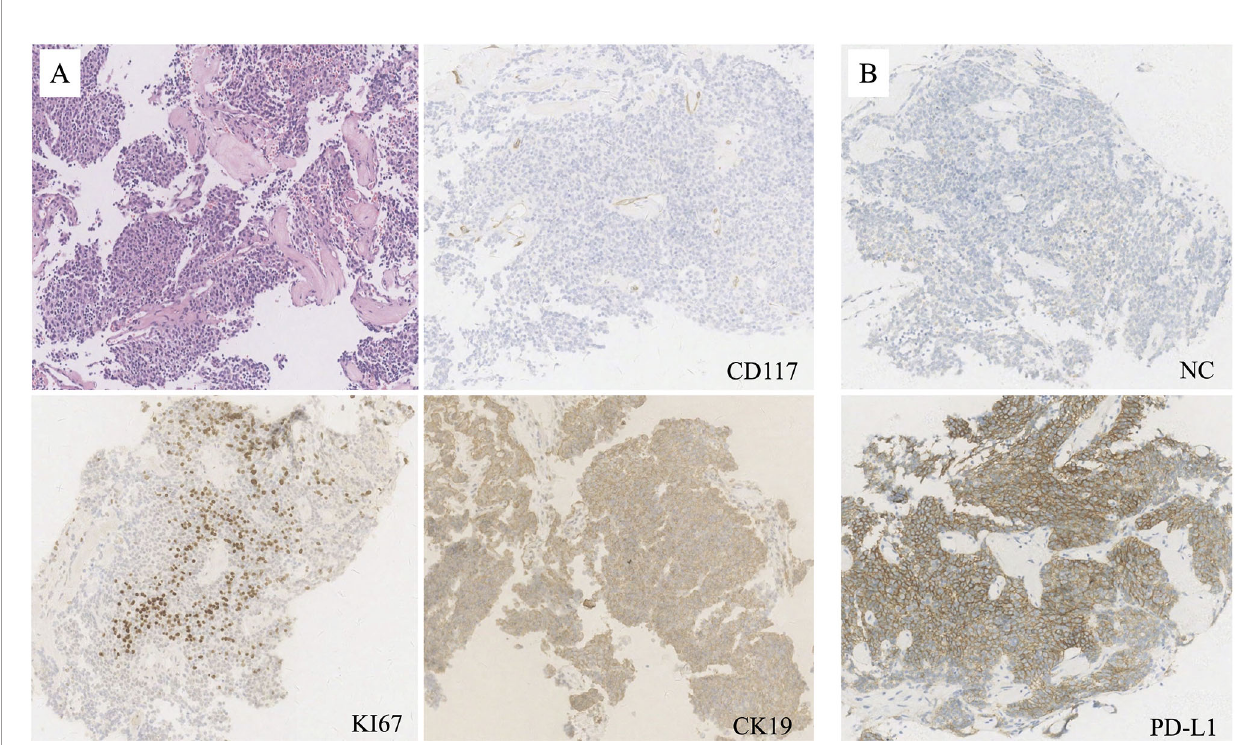
FIGURE 1 | (A) Mediastinal needle biopsy indicated type WHO type B3 thymoma (hematoxylin and eosin; original magni fi cation, ×50), with negative staing of CD117, but positive sating of KI67 and CK19 (immunohitochemistry; original magni fi cation, ×50). (B) PD-L1 was strongly expressed by 80% of all neoplastic thymic epithelial cells (immunohitochemistry; original magni fi cation,